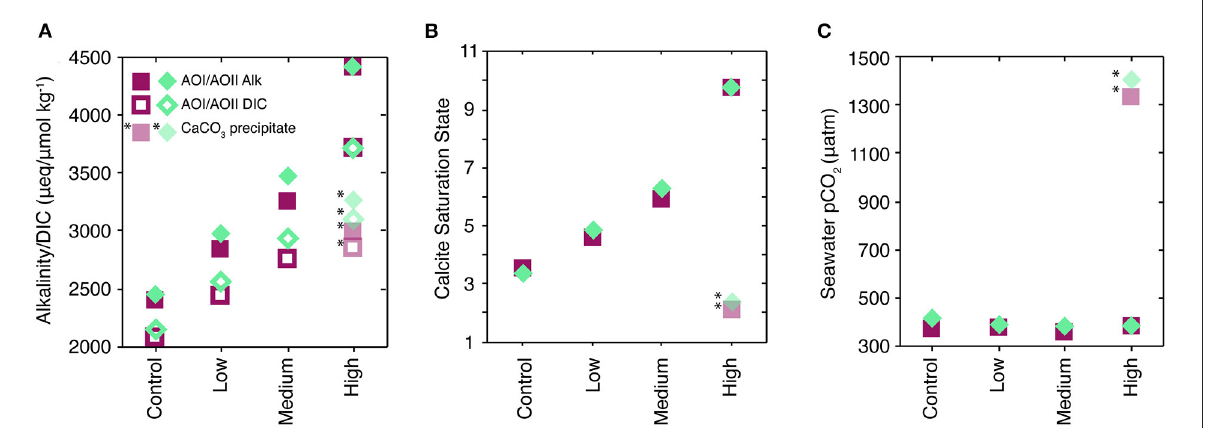
FIGURE2 Carbonate system parameters for the experiments. All AOI symbols are magenta squares; all AOII samples are teal diamonds. (A) Shows adjusted alkalinity (Alk; filled symbols) and DIC (open symbols) for each treatment type, shown as the mean of final triplicate and initial t 0 values. Note that the “control” case was only spiked with ∼ 5 µ mol kg − 1 13 C-bicarbonate, and essentially represents the in situ carbonate system. CaCO 3 precipitation during sample storage led to anomalous measured values for the “High” treatment, indicated by the semi-transparent, starred symbols in each panel; see text for details. (B) Shows the calcite saturation state for each of the treatment types, using the Alk and DIC values from (A) . (C) Shows seawater pCO 2 calculated for each of the treatment types.